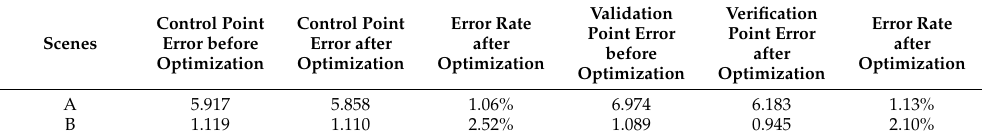
Table 4. Linear distance error results of experimental latitude and longitude points (unit: m).